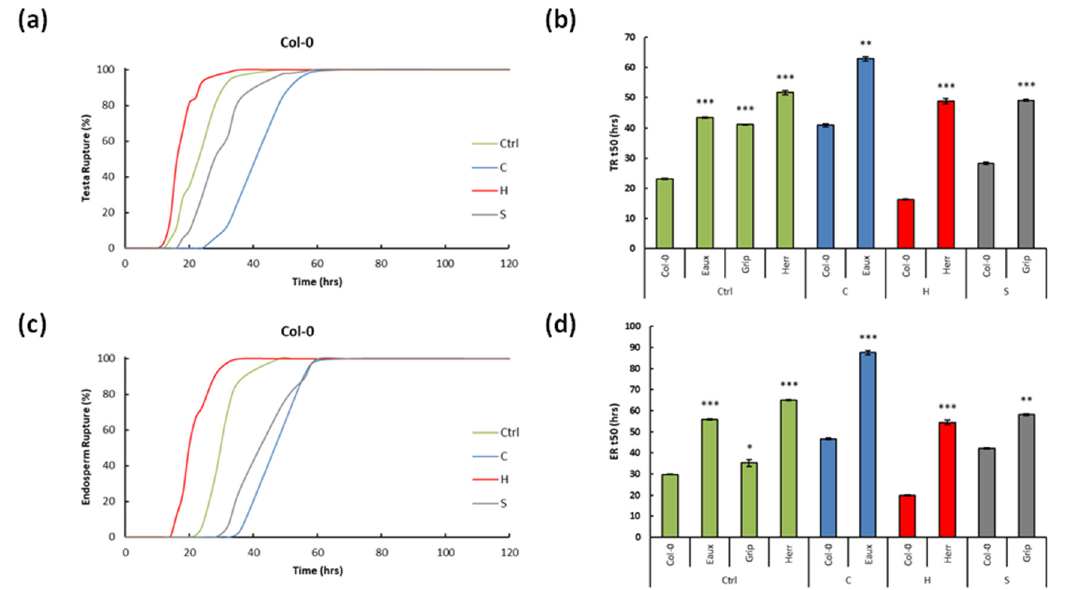
Figure 3. Line graphs showing ( a ) the testa and ( b ) the endosperm ruptures over time (hours) in Col-0 under the four tested conditions; bar graphs revealing the median germination time t50 (hrs) of ( c ) the TR and ( d ) ER of Col-0 and the selected Pyrenean populations under the designed treatments: Col-0 and Eaux under C, Col-0 and Herr under H, and Col-0 and Grip under S. (***) p -value < 0.0001, (**) p -value < 0.001, and (*) p -value < 0.01 of the Student’s t -test of the pairwise comparisons between Col-0 and the Pyrenean populations at each treatment. The error bars correspond to the standard error of means (SEM).